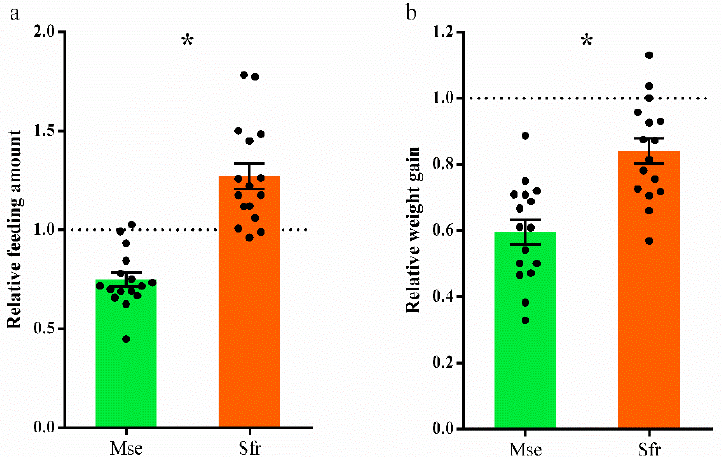
Figure 5. Larval performance of Mythimna separata and Spodoptera frugiperda on cholestanone. ( a ) Relative food intake and ( b ) relative weight gain during the 4th and 5th instars were presented. The dotted line represents where the insects consumed the same amount of food ( a ) or had the same level of weight gain ( b ) between the cholesterol diet and the cholestanone diet. Data are calculated from 16 biological replicates and shown as means ± standard errors. * represents a significant difference at p < 0.